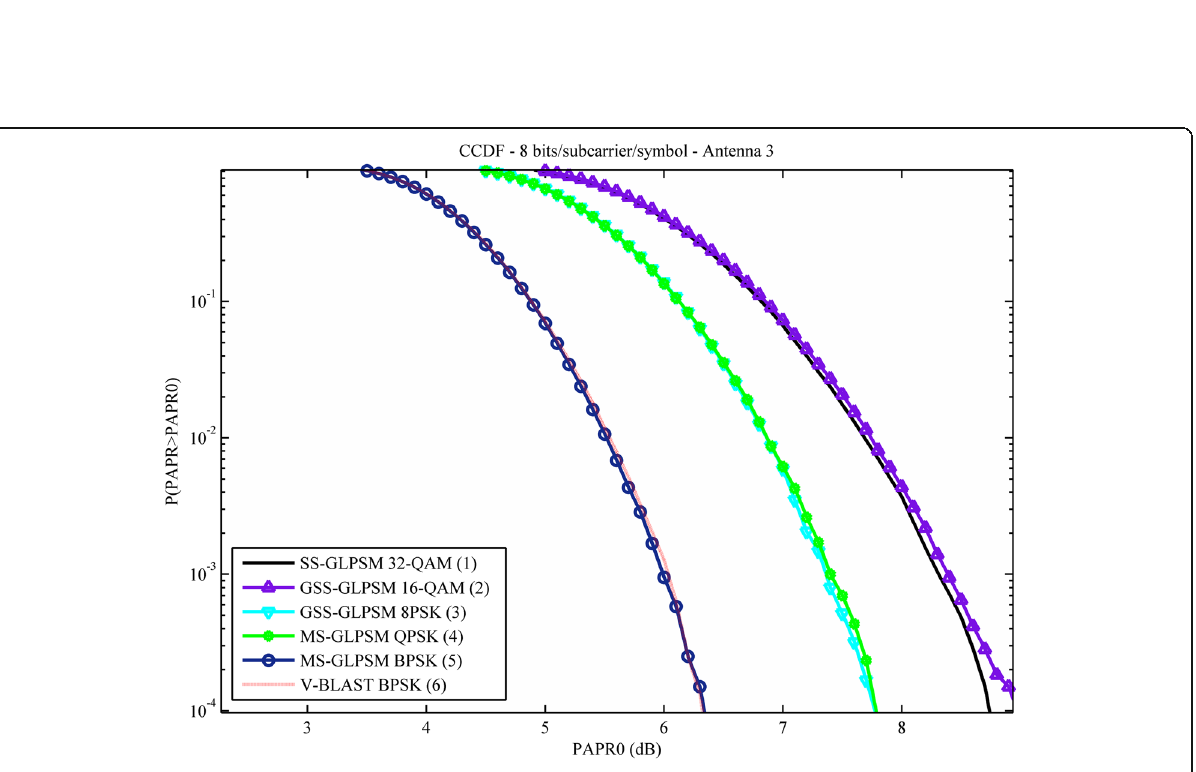
Fig. 5 PAPR comparison for SC-FDMA GLPSM and SC-FDMA V-BLAST with the parameters given in Table 1. In order to have a full comparison